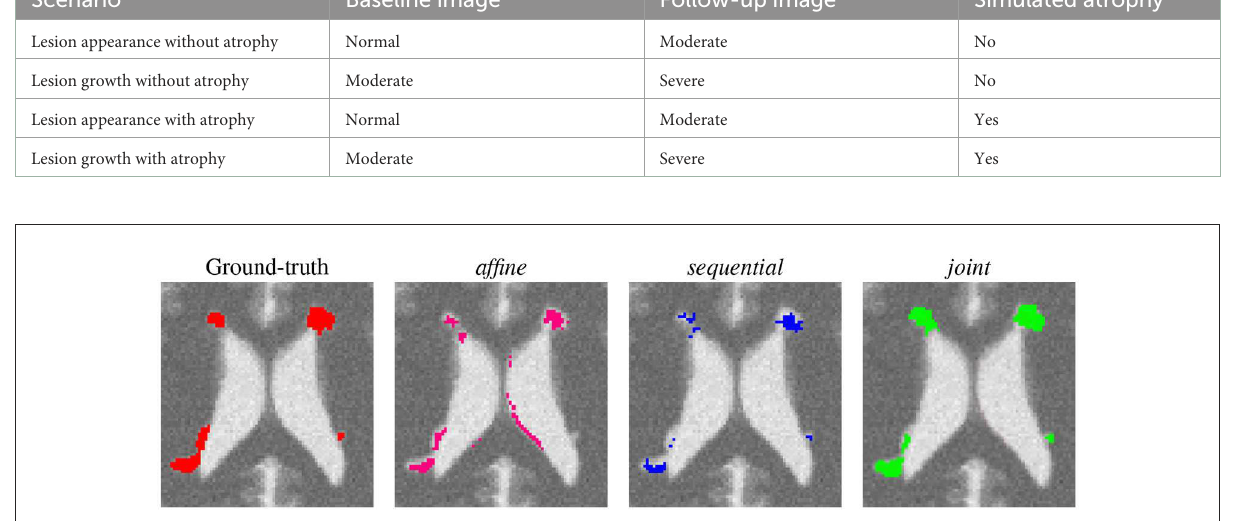
registration to be consistent with the underlying